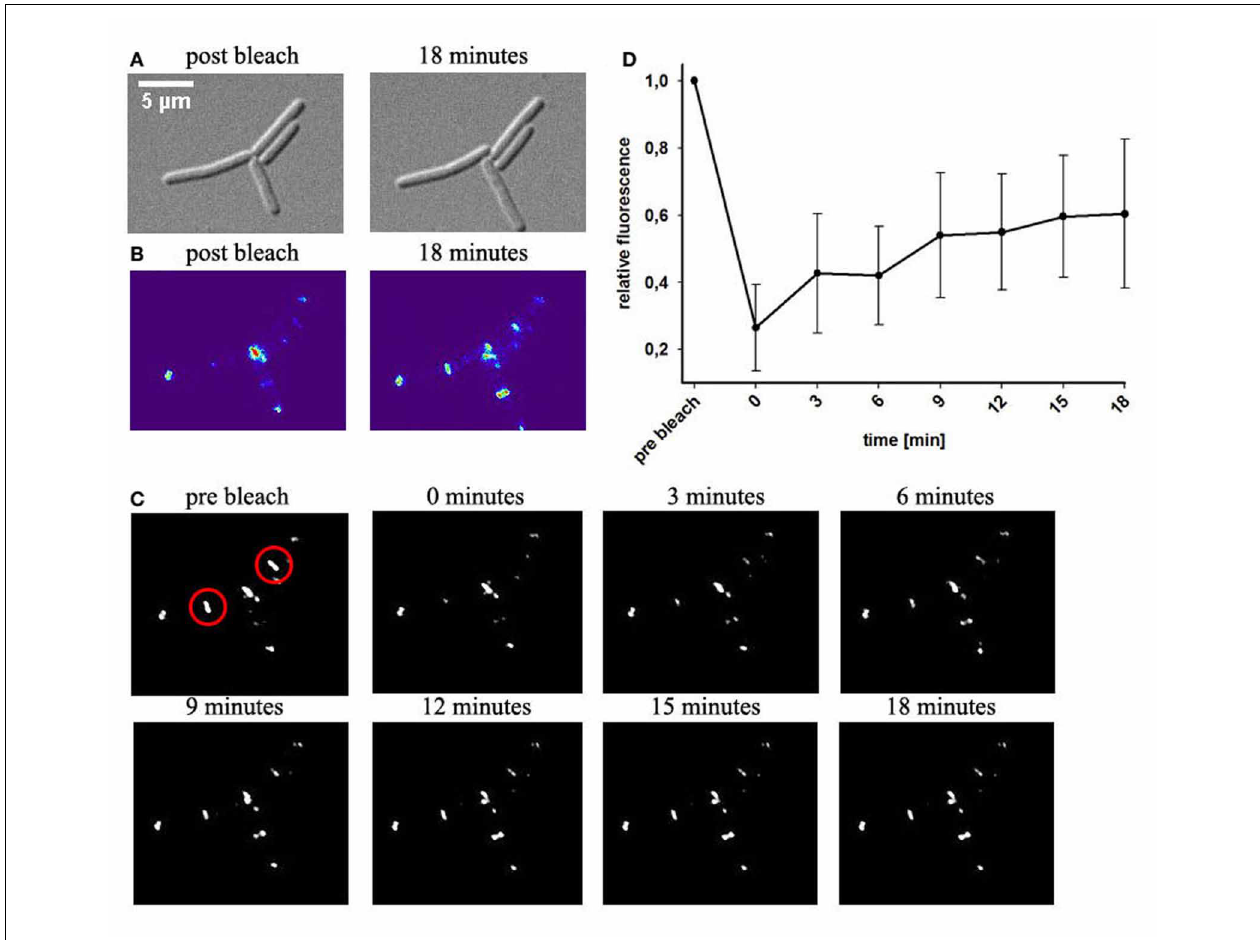
FIGURE 2 | Fluorescence recovery after photobleaching of DivIVA-GFP. Cells expressing DivIVA-GFP under control of the native promoter were grown on agarose slides supplemented with LB. (A) DIC images of B. subtilis cells expressing DivIVA-GFP directly after a bleaching event and after 18min are shown (B) Heat maps of the GFP signal and time